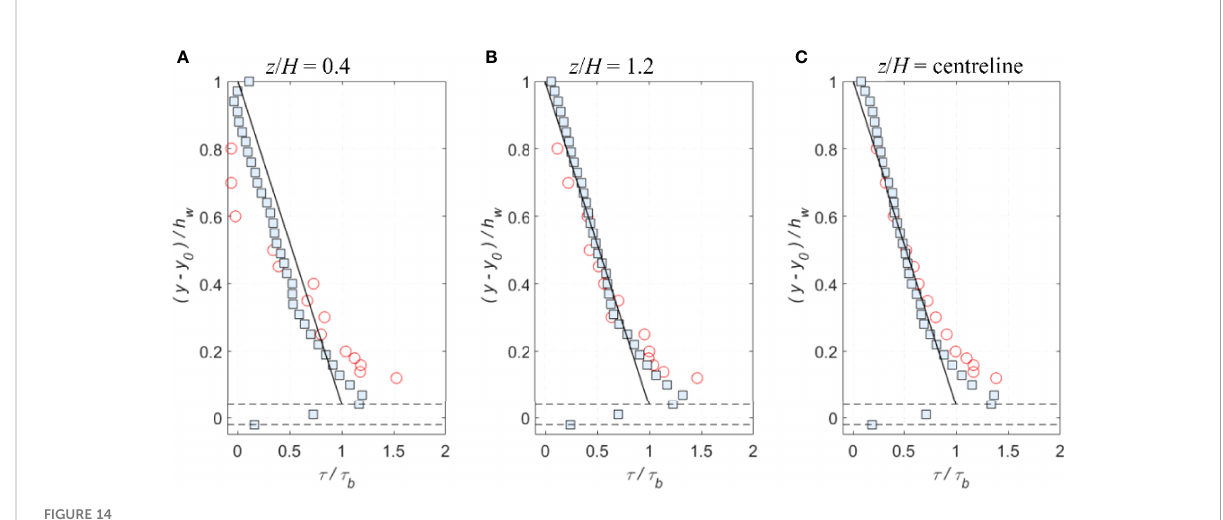
FIGURE 14 (A – C) Comparisons of the lateral pro fi les of time-averaged shear stress between experimental, analytical and SPH results for deep fl ow condition 4 (circles: exp data; squares: SPH; solid black lines: analytical; and dash lines: roughness top and